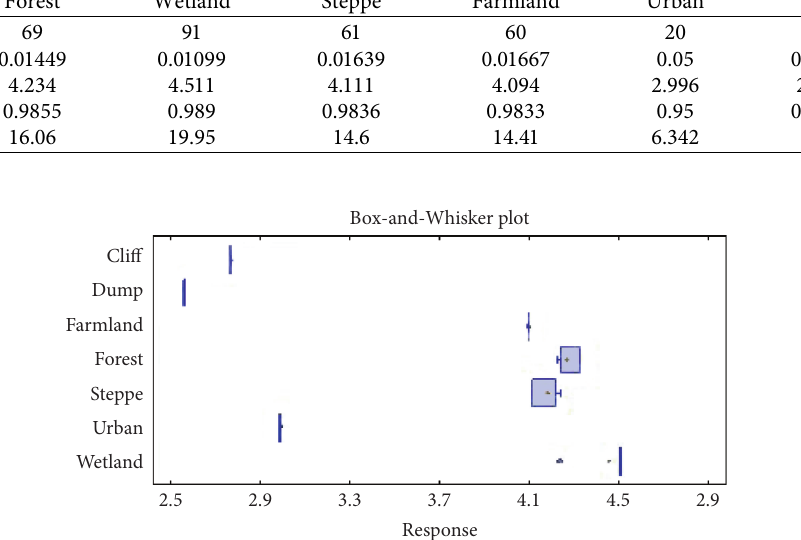
Figure 3: Comparison (graphical ANOVA) of avifauna diversity among studied habitats at Midelt province.